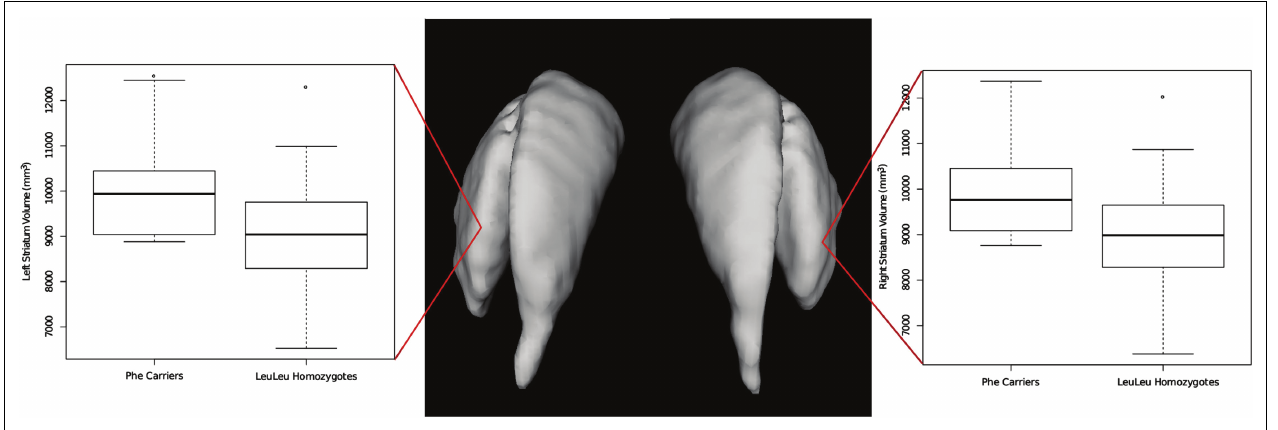
FIGURE 1 | Differences in left and right striatal volume based on the Leu607Phe genotype. Phe carriers exhibit larger striatal volume